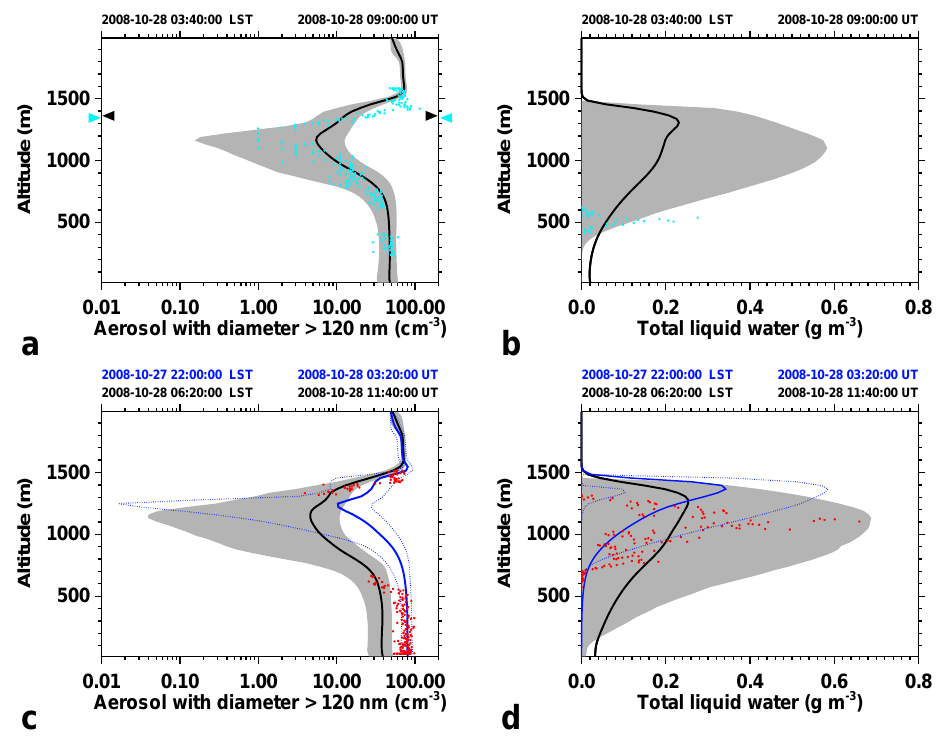
Fig. 9. Comparison of results from simulation S 0 (black and blue) with VOCALS-REx RF06 POC observations at 09:05UT (cyan dots) and at 11:36UT (red dots). Solid curves denote the model mean, gray shading and dotted blue curves model values between the 10th and 90th percentile. Cyan and black triangles mark the observed and simulated mean cloud top height, respectively. Panel (a) and (c) show average concentrations of aerosol particles > 120nm dry diameter at cloud-free locations. The observed aerosol concentrations, measured by the PCASP instrument on board the NCAR C-130 aircraft, are plotted only at locations with a liquid water content < 0 . 03gm − 3 and a rain drop number < 0 . 001cm − 3 in order to exclude artifacts from shattering of cloud and rain droplets. The model results represent aerosol concentrations at locations with a cloud water content < 0 . 01gkg − 1 . Panel (b) and (d) show liquid water (sum of cloud and rain water) mixing ratios averaged over cloudy and cloud-free locations; the observed values were measured by the 2D-C probe on board the NCAR C-130